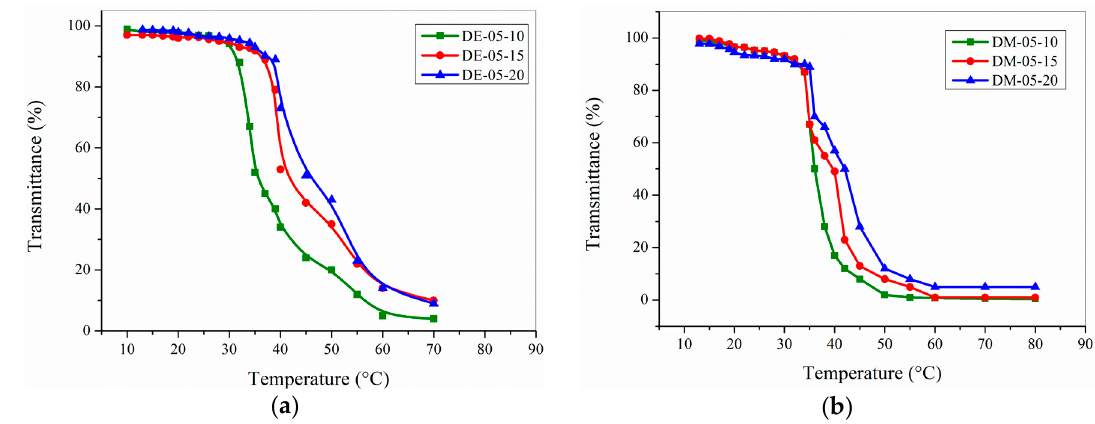
Figure 2. Turbidity measurements of functional thermo-responsive polymers for: ( a ) DEAMVA in water; ( b ) DMAMVA in water (1 wt % of polymer solution). Table 2. Characterization of functional photo cross-linkable smart polymers based on vanillin derivatives VA, DEAMVA and DMAMVA.